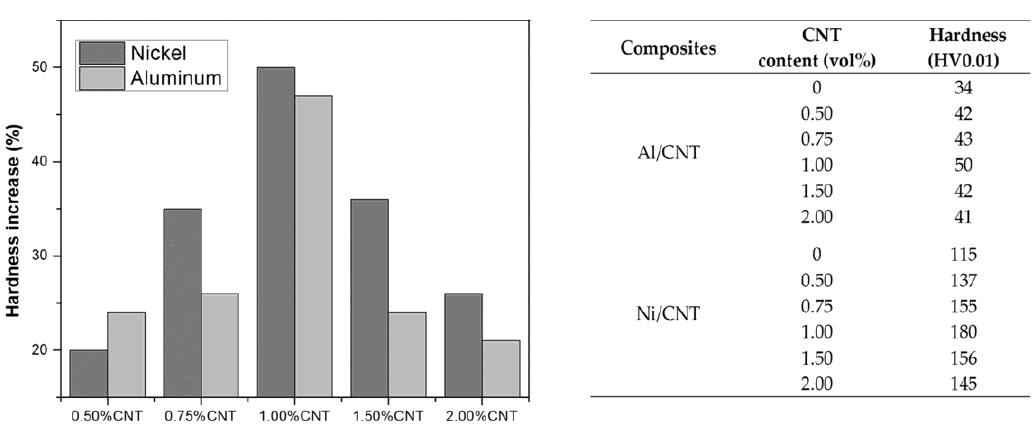
Figure 8. The increase in the hardness (HV 0.01) of the nanocomposites relative to pure metallic matrices. The hardness values of all samples are listed in the